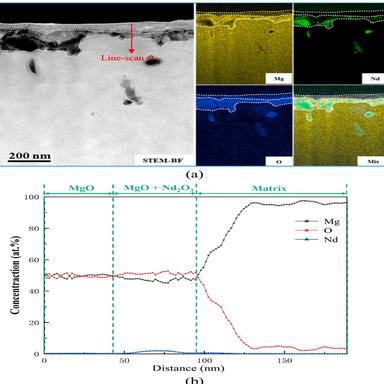
(a) STEM-BF image and corresponding EDS elemental distribution maps of the region free of Mg12Nd precipitate after oxidation for 1 h; (b) EDS line-scan 2 showing the elemental distribution across the duplex surface oxide scale in (a).